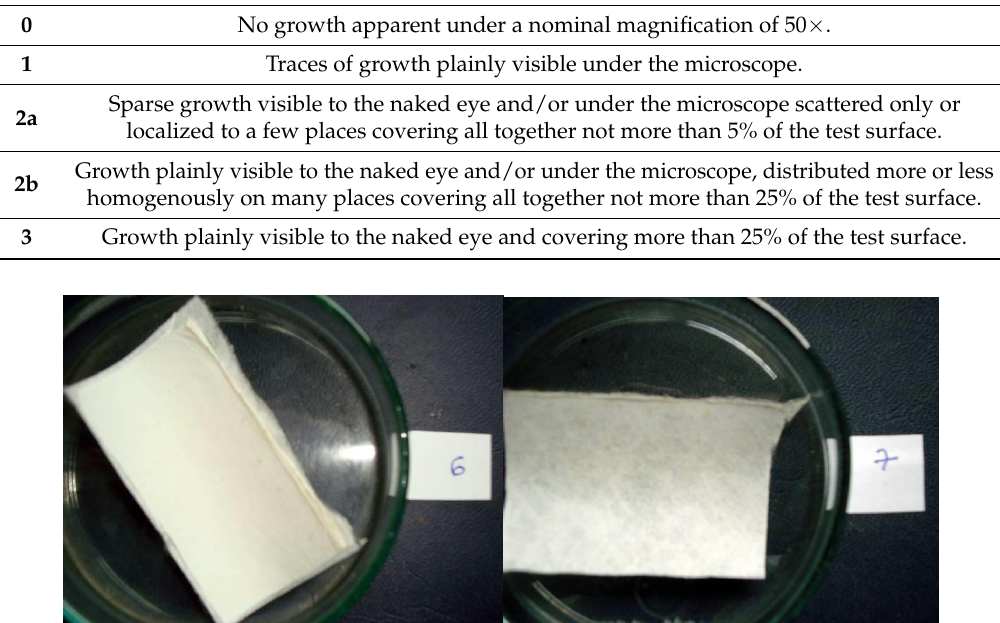
Table 6. Mold resistance assessment according to SRPS EN 60068-2-38 norm.